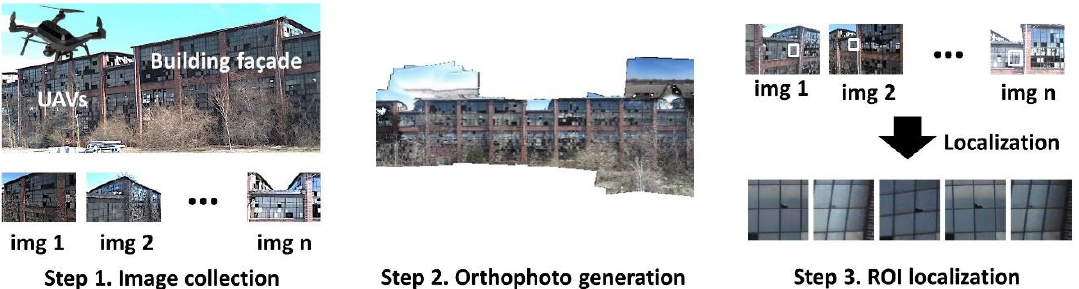
Figure 1. System overview: Step 1. Image collection—collecting many close-up images to cover the entire area of a building façade under various viewpoints, Step 2. Orthophoto generation—constructing an orthophoto of the building façade and computing a geometric relationship between the constructed orthophoto and each image, and Step 3. Regions-of-interest (ROI) localization—extracting the ROIs from the images.